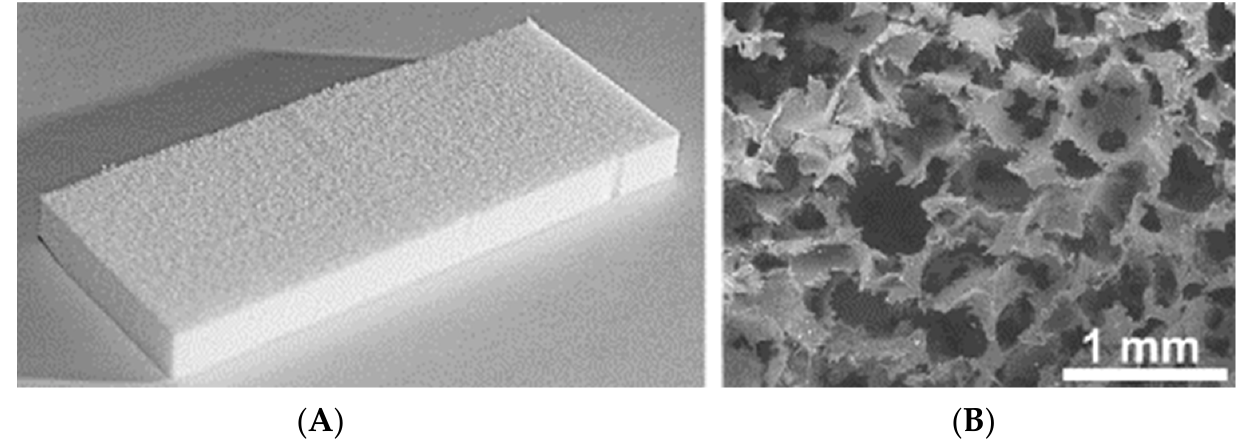
Figure 1. Image ( A ) and Scanning Electron Microscopy micrograph ( B ) of the porous UHMWPE sample. 2.1. Growth of SH-SY5Y Cells and Primary Hippocampal Cell Cultures on UHMWPE